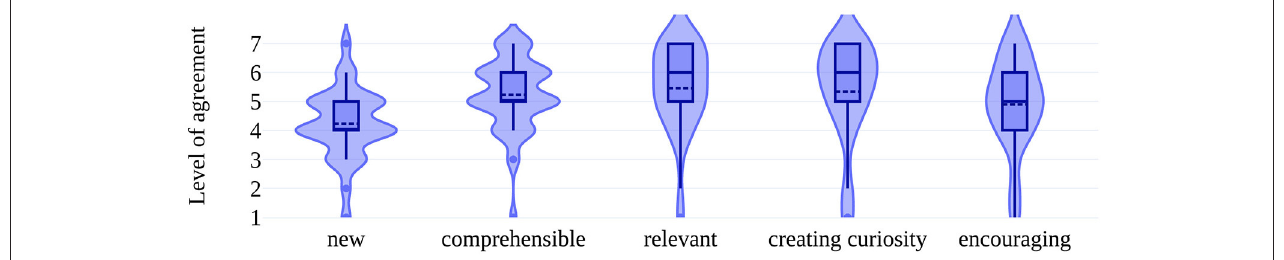
FIGURE 2 | Participants’ website experiences. Data in violin plots. The level of agreement on the y -axis was assessed on a 7-point Likert-scale ranging from 1 = very low agreement to 7 = very high agreement. Categories are shown on the x -axis. The extension from the center line is proportional to the density of data to the given y -value. The box plot inside gives upper and lower adjacent values, interquartile ranges, median and shows outliners (light blue dots). Additionally, the mean is shown with a dark blue dotted line.